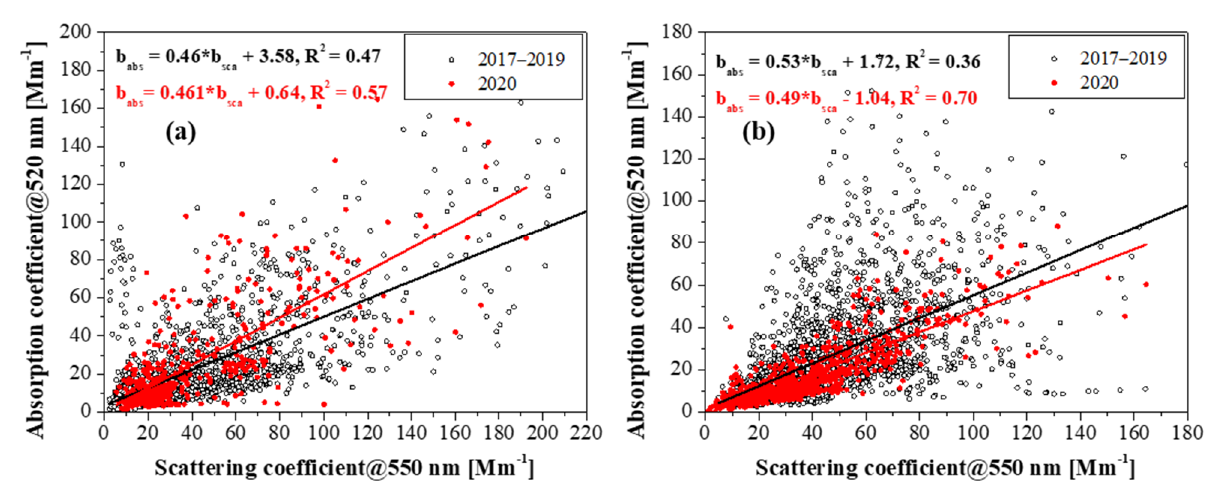
Figure 4. Correlation between scattering and absorption coefficients for the March 1–22 ( a ) and 23 March 23–4 May ( b ) periods of 2017–2019 and 2020.